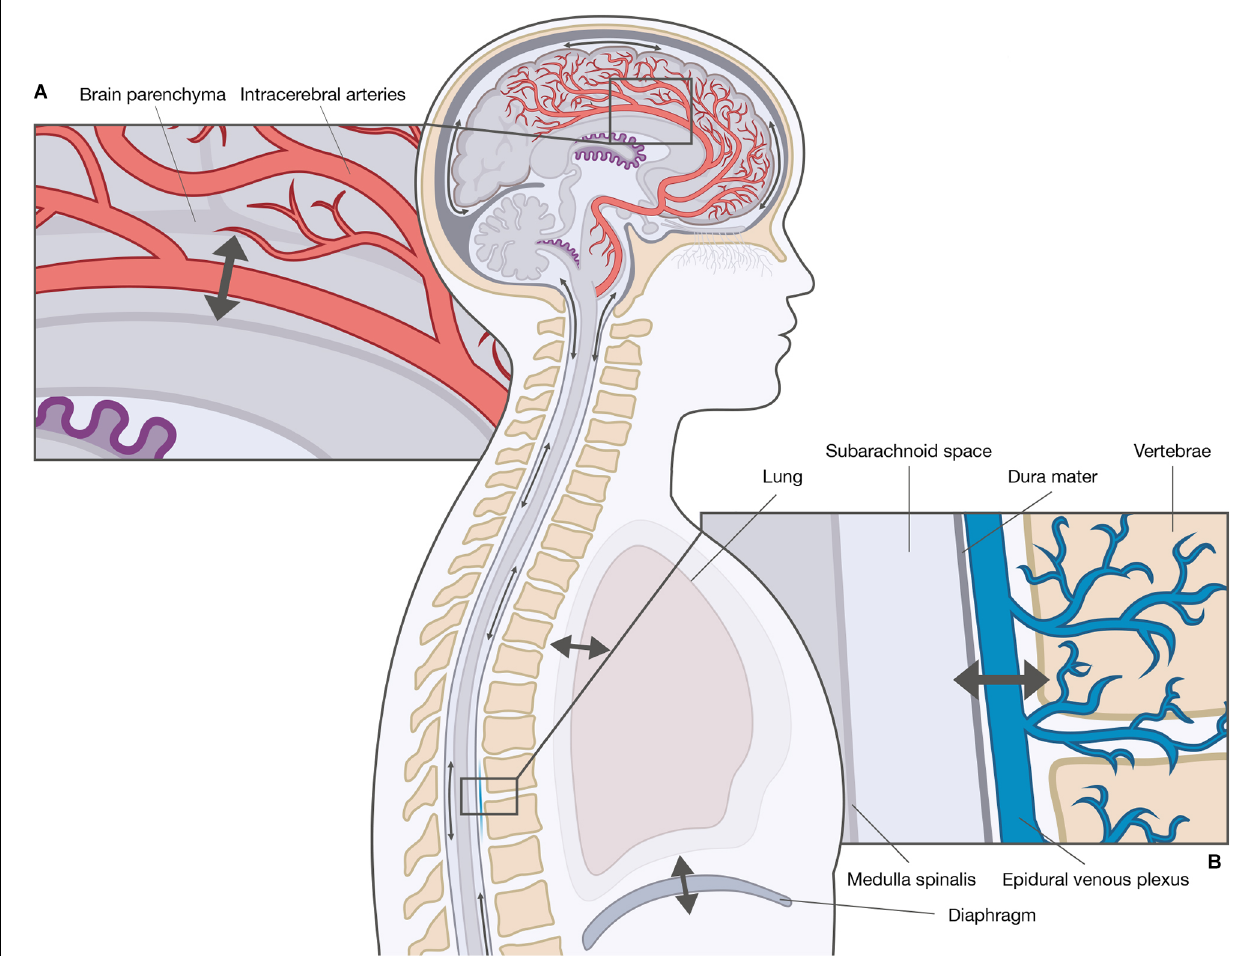
FIGURE 2 | Driving forces of cerebrospinal fluid (CSF) movement within the ventricles and subarachnoid spaces. The movement of CSF is convective and pulsatile. The two main driving forces of the pulsatile CSF movement are the cardiac-driven force and the respiratory-driven force. These forces influence the arterial blood and the venous blood differently, and thereby CSF movement to a different extent. (A) The cardiac-driven force causes a change in blood volume leading to pulsations that are transmitted directly or indirectly to the CSF. (B) The respiratory force consists of thoracic respiration and diaphragmatic respiration. Both types of respirations influence the CSF movement through the venous system, e.g., epidural venous plexus by changes in the intrathoracic